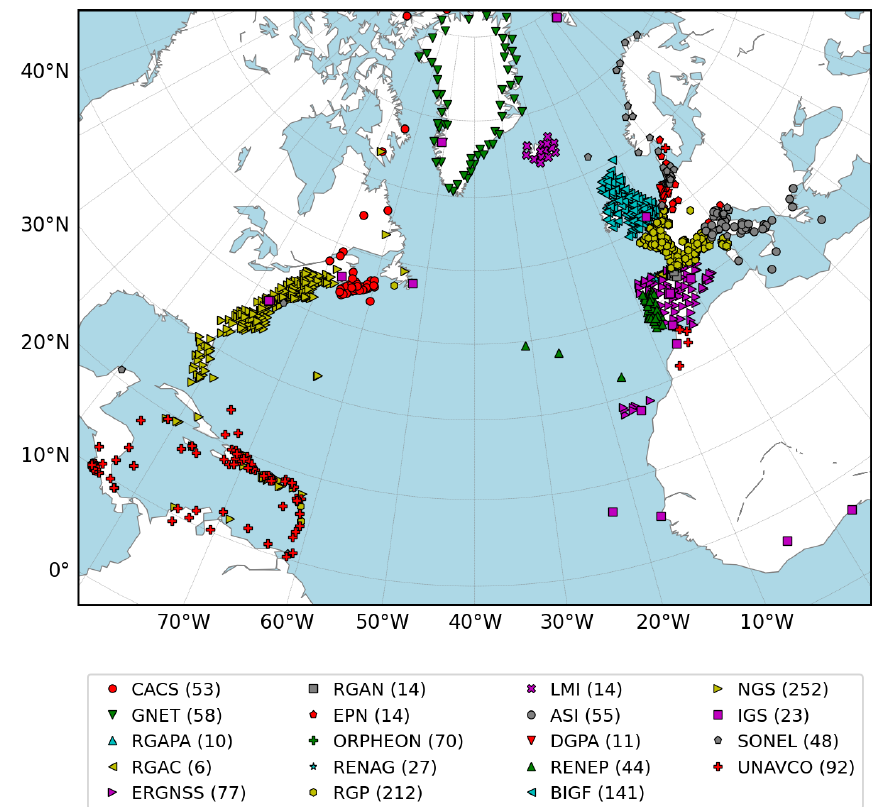
Figure 1. Map of the 1221 GNSS stations for which measurements were processed in the framework of the NAWDEX project. The symbols represent the 19 data providers from which data were collected (see the legend at the bottom with the corresponding number of